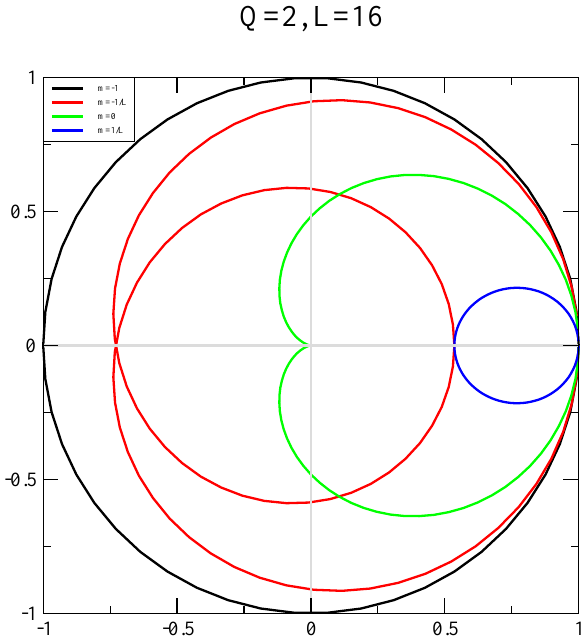
1 (black), 1/ L (red), 0 (green), 1/ L − −